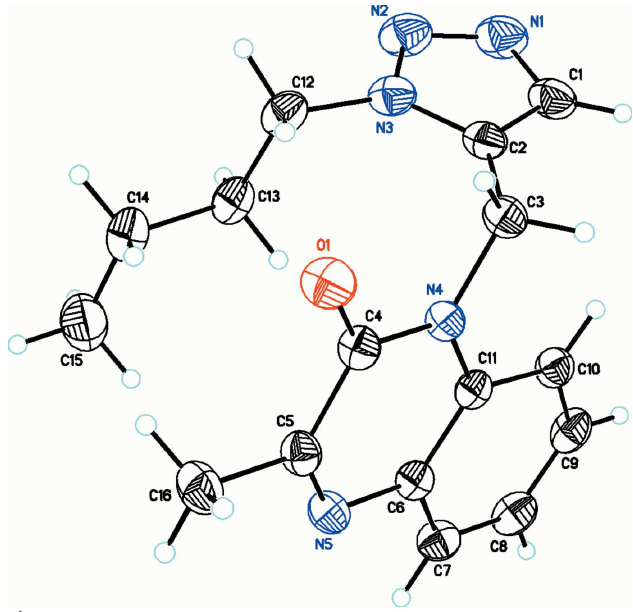
Figure 1 A view of the molecular structure of the title compound, showing displacement ellipsoids drawn at the 30% probability